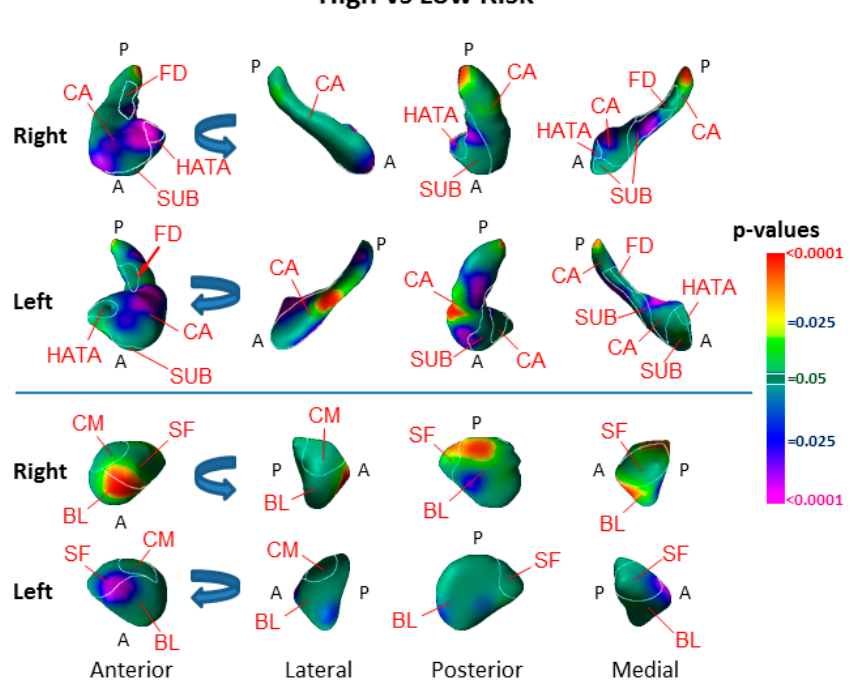
Figure 2. Main Effect of Risk Group on Surface Morphologic Features. The right and left hippocampus and amygdala are shown in their anterior, lateral, posterior, and medial views, with the overlaid cytoarchitectonic map shown in the thin white outlines. Anterior (A) and posterior (P) positions are indicated. Arrows in the rotational views show the direction of rotation. The statistical significance (probability values) of differences in surface morphology across risk groups (81 high-risk, 67 low-risk participants) are color coded at each point on the hippocampal and amygdala surfaces. The color bar indicates the color coding for p -values associated with the main effect of risk group, with warmer colors (yellow and red) indicating protruding surfaces, presumably from larger underlying volumes, and cooler colors (blue and purple) indicating indented surfaces and presumably smaller underlying volumes in those regions. p -values are thresholded at p < 0.05 after correction for multiple comparisons using FDR. The statistical model included the main effect of risk group and the covariates of age, age 2 , and sex. Abbreviations: A—anterior; P—posterior; CA—cornu ammonis;